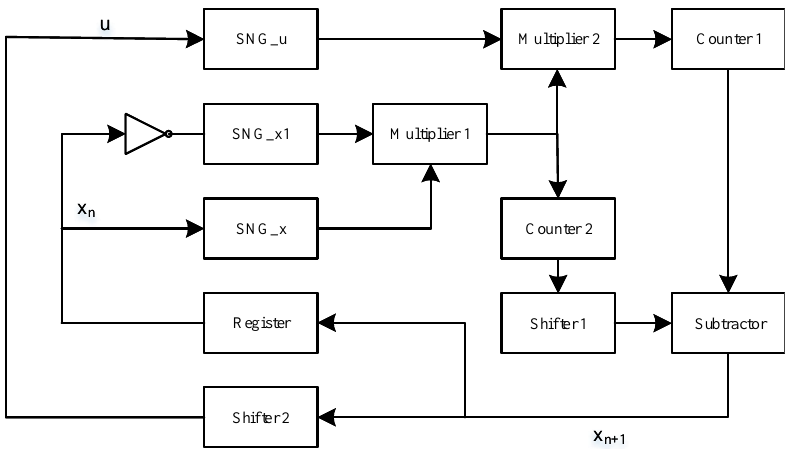
Figure 7. The hardware structure of the PRNG based on the enhanced logistic map.